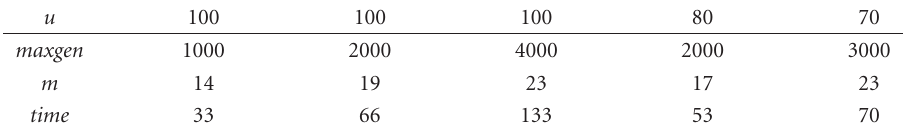
Table 4.5. Search results of 5 di ff erent parameter values for a 14-dimensional set by our approach. u 100 100 100 80 70 maxgen m